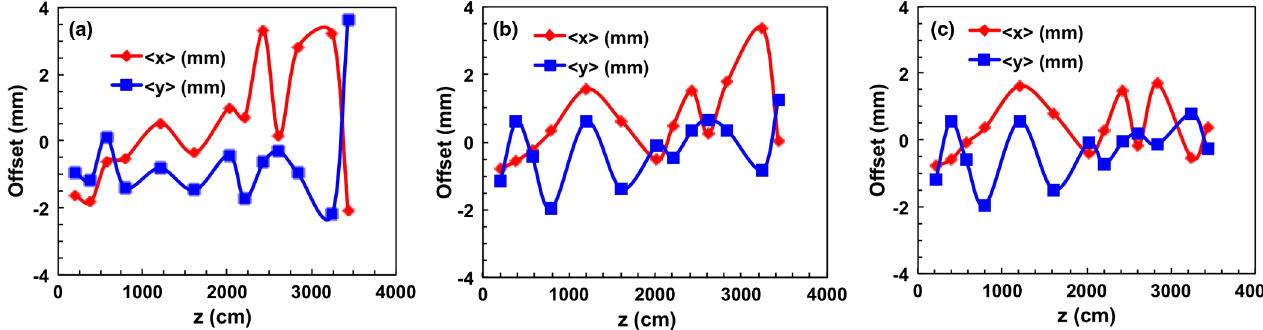
FIG. 8. Measured beam centroid offsets up to BPM19 with (a) nominal dipole settings for a lower field tune, (b) corrected with dipoles A , M , 33, and 36, and (c) corrected with dipoles A , M , 33, 36, 57, and 60.